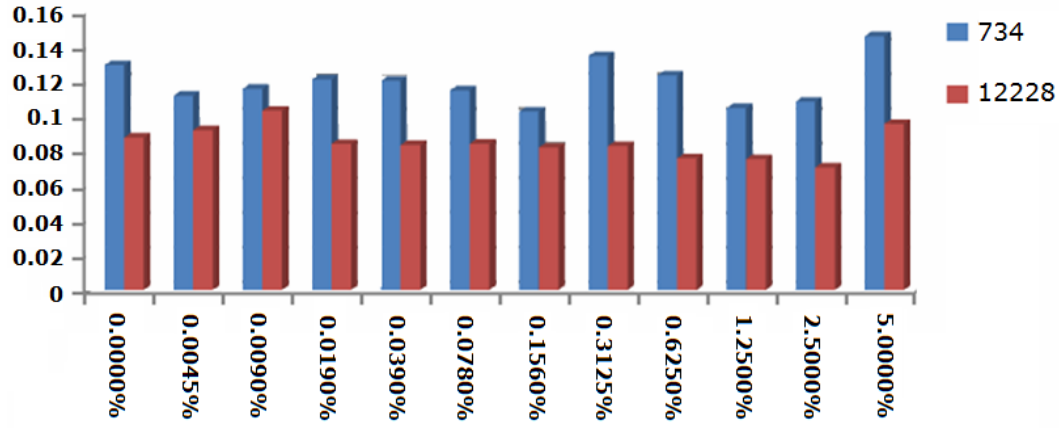
Figure 2. Low concentration (5%) of maggot ES, S.epidermidis 734 biofilm formation was extremely induced compared to S. epidermidis ATCC12228. It was observed using microtiter plate biofilm assay with or without maggot ES. Measurement performed three times. Horisontal line indicated concentrations of ES, whereas vertical line indicated biofilm